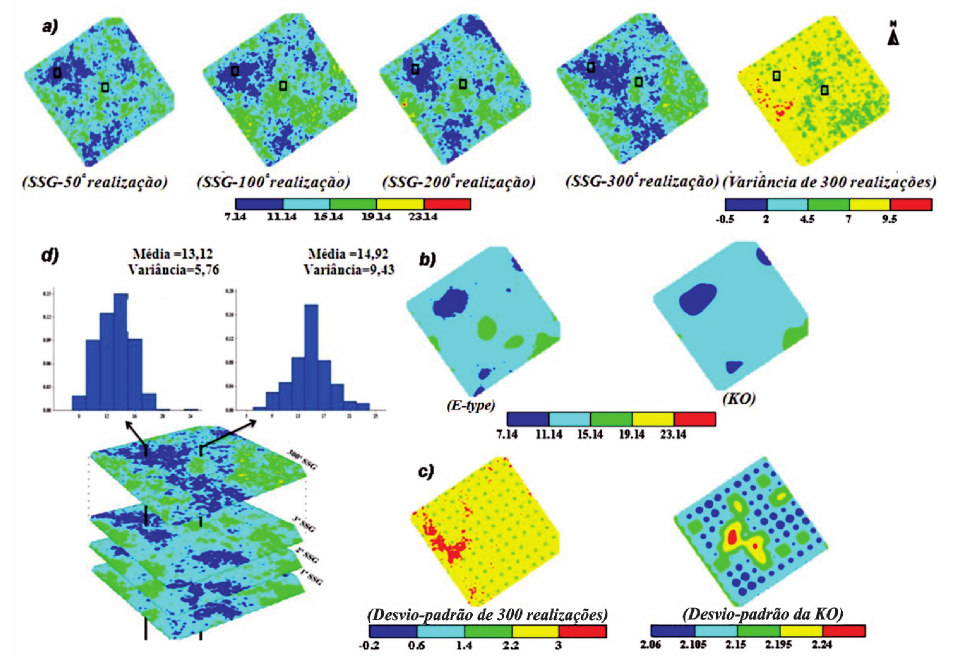
Figura 3. Mapas das realizações (50ª, 100ª, 200ª e 300ª) e variância de 300 realizações (a), mapas das estimativas E-type e KO (b), mapas do desvio-padrão de 300 realizações e da KO (c) e incertezas locais de dois pontos da área (d) dos teores de Gt na pedoforma